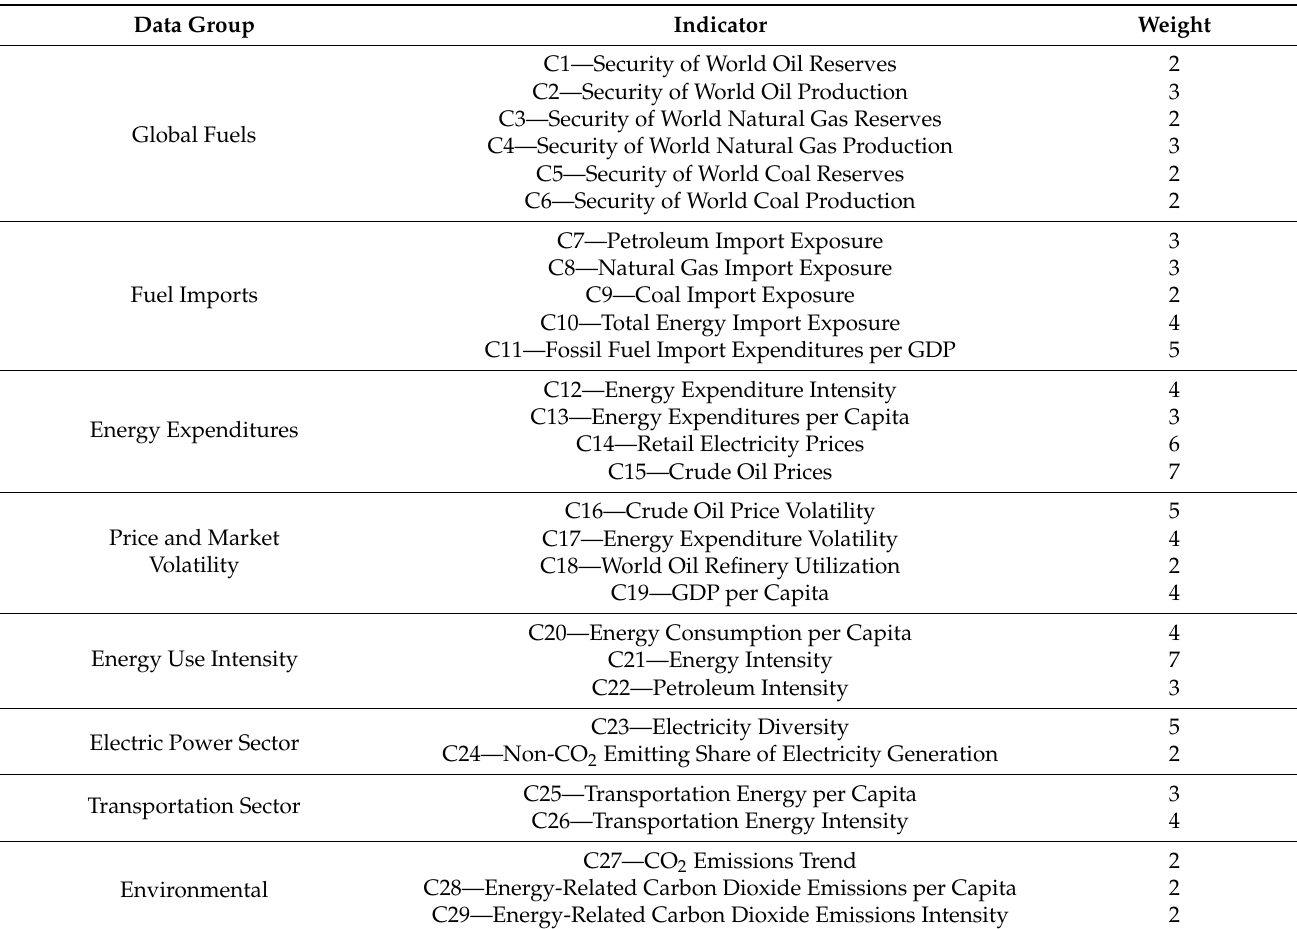
Table 3. Detailed indicators included in the IESRI